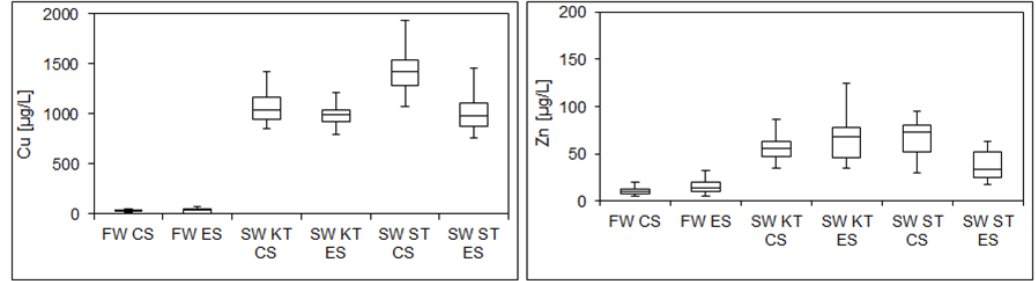
Figure 2. Copper ( left ) and zinc ( right ) concentrations in fresh water (FW) and stagnant water (SW) in the conventional (CS) and extended (E-S) system at the kitchen tap (KT) and shower tap (ST). Number of fresh samples (inlet, kitchen and shower) = 48. Number of samples per tap = 16, SDcopper < 2.5%, SDzinc < 2.8%.